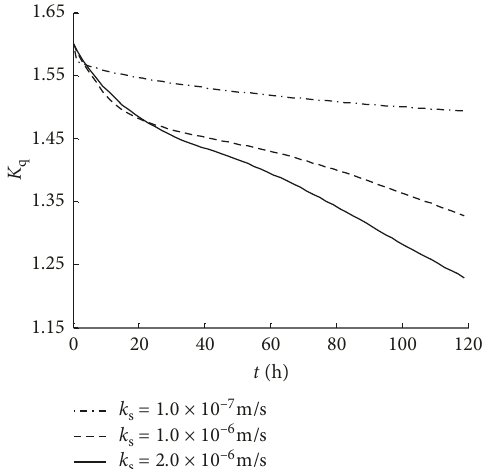
Figure 4: Effect of saturated permeability coefficient on safety coefficient. Figure 5: Effect of water table of active area on safety coefficient.